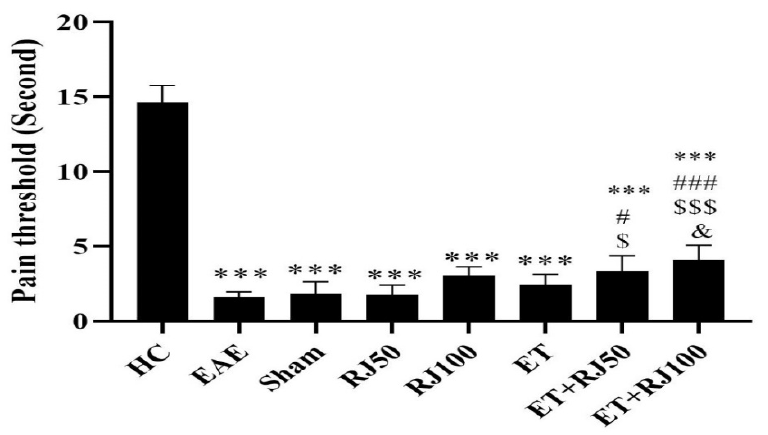
Figure 3. PT levels in rats in the groups of study. EAE reduced PT in all EAE-induced groups, while ET + RT50 and ET + RJ100 augmented PT. Each value is the mean ± SD. *** ( p ≤ 0.001): significant decrease compared to the HC group. # ( p ≤ 0.05) and ### ( p ≤ 0.001): significant increase compared to the EAE group. $ ( p ≤ 0.05) and $$$ ( p ≤ 0.001): significant increase compared to the RJ50 group. & ( p ≤ 0.05): Significant increase compared to the ET group. Healthy control (HC); experimental autoimmune encephalomyelitis (EAE); 50 mg/kg royal jelly (RJ50); 100 mg/kg royal jelly J (RJ100); exercise training (ET); exercise training + 50 mg/kg royal jelly (ET + RJ50); exercise training + 100 mg/kg royal jelly (ET +